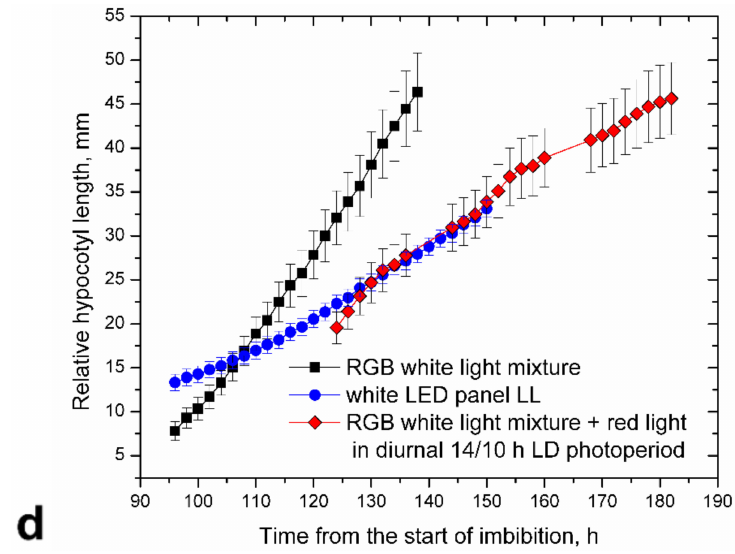
Figure 3. Hypocotyl elongation in plantlets grown in free-running monochromatic light is rapid and uniform. ( a ) Cumulative hypocotyl length increase under the green (GG), red (RR), yellow (YY), and LL, i.e., an RGB mixture of blue, red and green light. The elongation rates were similar but treatments differed with respect to the time at which the hypocotyls began to elongate. Elon- gation under the blue light (BB) was much faster and could be grouped with elongation in true darkness (DD). ( b ) Comparison of hypocotyl elongation rates in diurnal (white-light LED panels + dark) photoperiods and free-running monochromatic light treatments with respect to the daily duration of the true nighttime (darkness) period. For free-running monochromatic light treatments, the duration of darkness was zero. ( c ) Elongation rates of plants grown under various monochromatic light colors compared to rate in diurnal moderately long day photoperiod. Elongation covered 24 h of the sixth day from the onset of germination. In monochromatic light, there was only a uniform type of hypocotyl elongation. ( d ) Hypocotyl elongation in LL conditions provided by light of white LED panels, with a radically different “white” RGB LED light mixture. When plants in the RGB LED light mixture were supplemented with additional 20 µ mol · m − 2 · s − 1 of red light, their elongation rate decreased to the elongation observed in plants under white LED panels. Suppressed elongation was also visible in the interpolated periods of